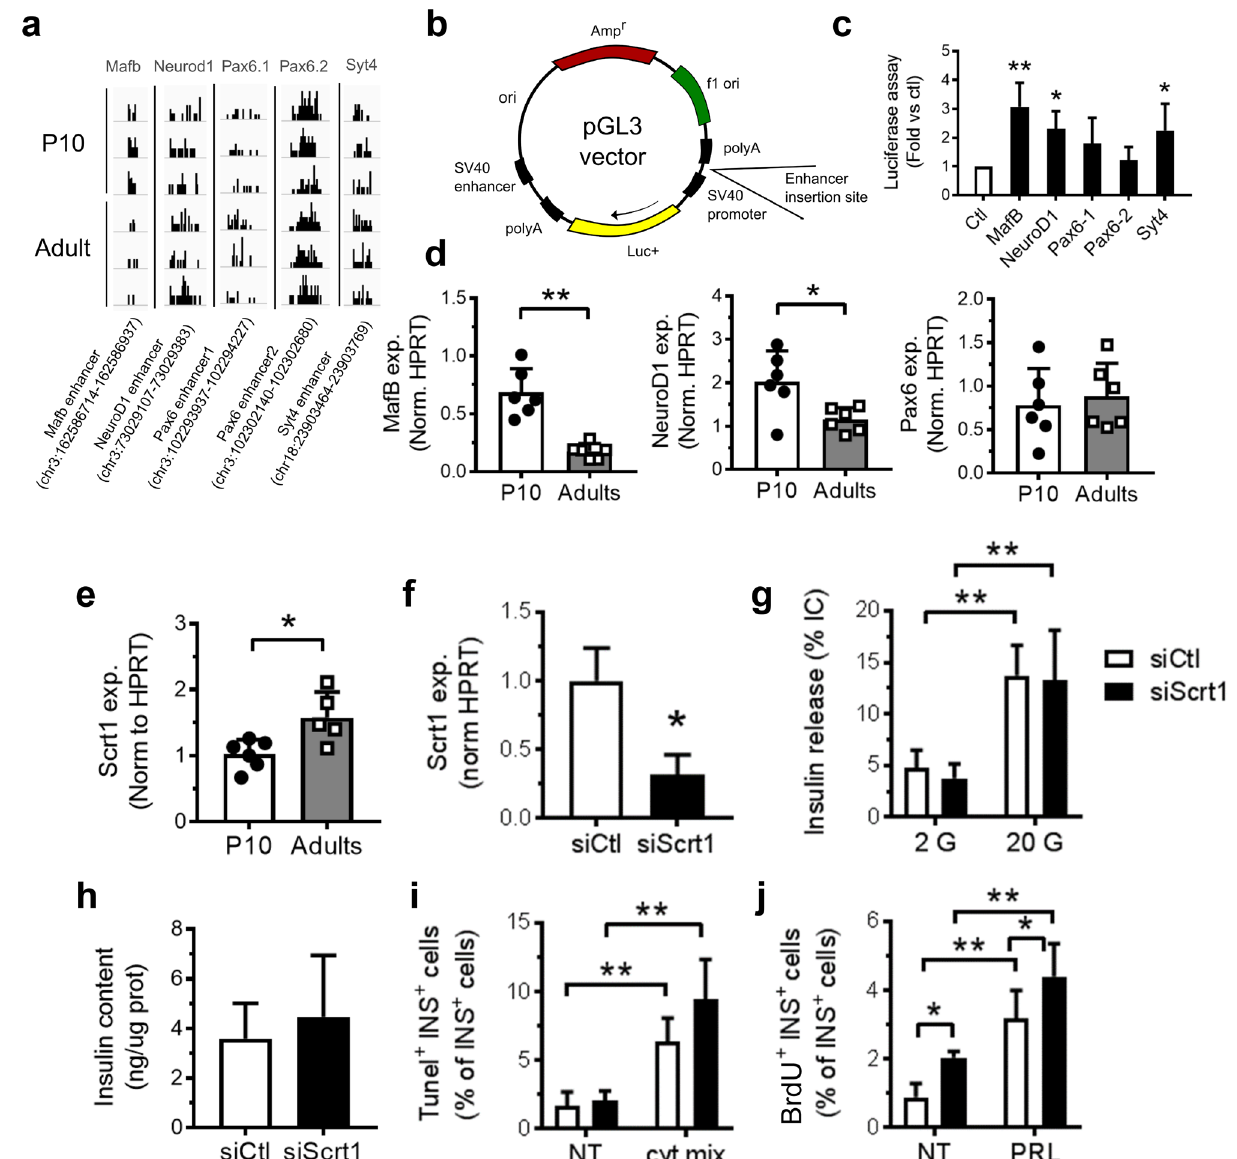
Figure 2. Enhancer activity assessment and Scrt1 function. ( a ) Trn5 integrations on Mafb, Syt4, Neurod1 and two Pax6 accessible sites. ( b ) Scheme of pGL3 vector used for the luciferase assay. ( c ) Luciferase activity was measured in INS 832/13 cells transfected with an empty pGL3 vector (Ctrl) or a pGL3 vector containing an enhancer region for the indicated gene ( Mafb, NeuroD1 , Pax6 and Syt4 ). Results are expressed as fold change versus control. ( d ) Gene expression in P10 and adult rat islets were measured by qPCR and normalized to the housekeeping gene Hprt1 . Syt4 gene expression is available in Fig. 3. * p < 0.05, ** p < 0.01 by Student’s t-test or by one-way Anova, Dunnett’s post-hoc test. ( e – f ) Scrt1 expression was measured by qPCR and normalized to Hprt1 housekeeping gene levels. ( f – j ) Dispersed adult rat islet cells were transfected with a control siRNA (siCtl) or siRNAs directed against Scrt1 (siScrt1). Experiments were performed 48 h post-transfection. Insulin release in response to 2 or 20 mM glucose ( g,h ) insulin content were determined by ELISA n = 3. ( i ) Apoptosis of insulin-positive cells was assessed using Tunel assay in basal (NT) condition or in response to a mix (cyt mix) of pro-inflammatory cytokines (IL-1β, TNF-α and IFN-γ) n = 5. ( j ) The fraction of proliferative insulin-positive cells was determined by BrdU incorporation in basal (NT) or stimulated (prolactin, PRL) conditions, n = 6. * p < 0.05, ** p < 0.01 by Student’s t-test or by one-way Anova, Tukey’s post-hoc test. See also Source data (4) and supplementary Fig.